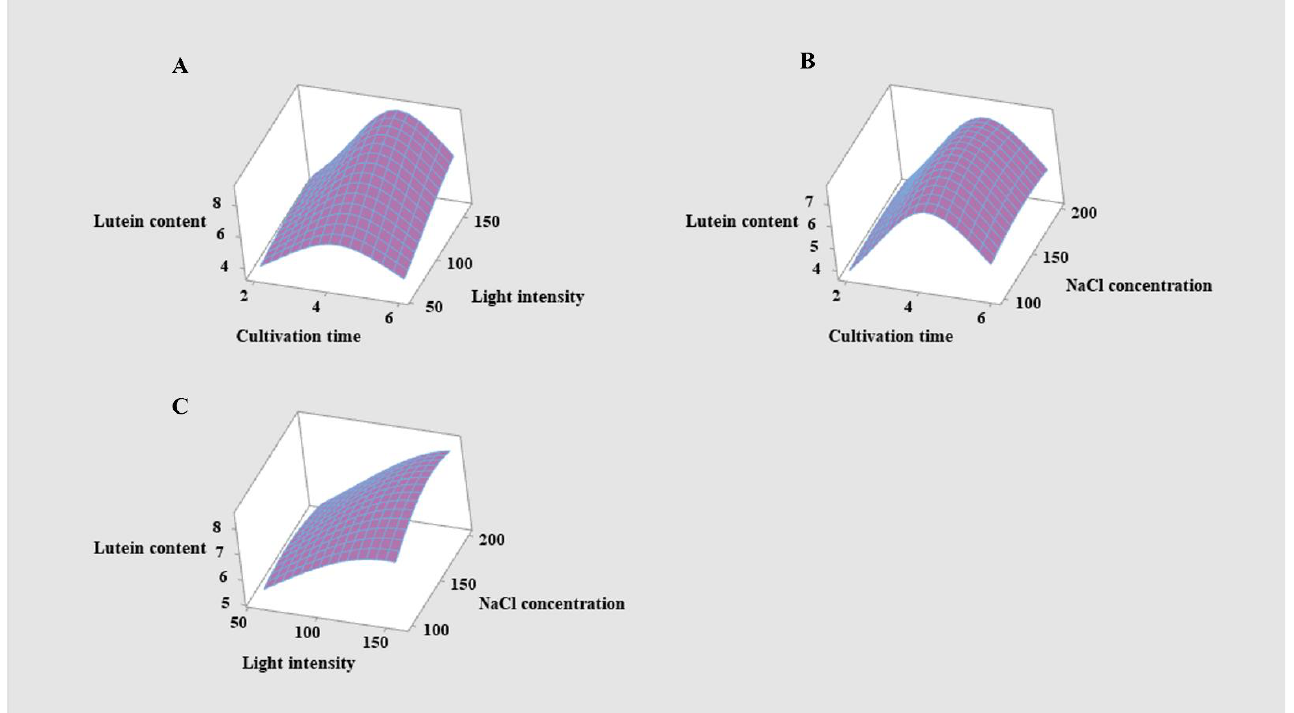
Figure 4. Response surface of lutein content. ( A ) Response surface for different light intensities and cultivation times on lutein content. ( B ) Response surface for different NaCl concentrations and cultivation times on lutein content. ( C ) Response surface for different light intensities and NaCl concentrations on the lutein content of Scenedesmus sp. FSP3.